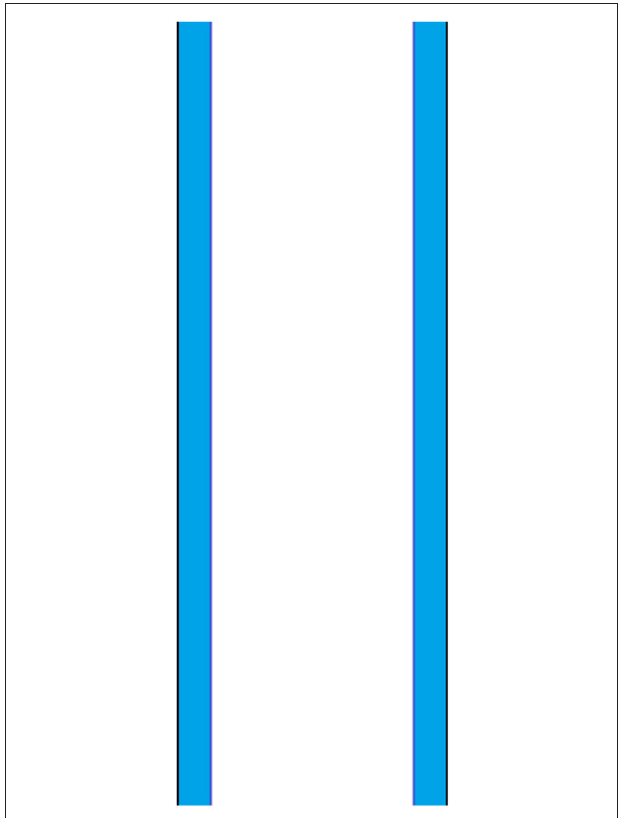
FIGURE 12 | Traversable wormhole with two